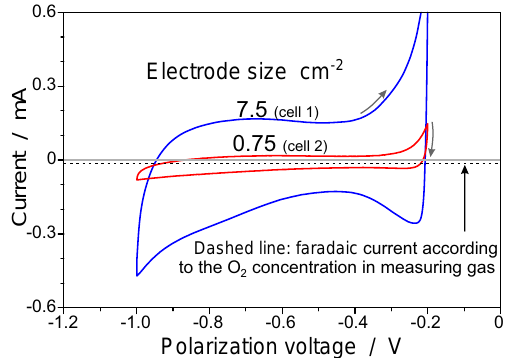
Figure 4. Voltammograms about the variation of the electrode size; measuring gas: 5vol.ppm O 2 in N 2 ; gas flow rate: 10sccm; cell temperature: 750 ◦ C; open-circuit potential: − 235mV; poten- tial scan rate: 200mVs − 1 ; start potential: − 0 . 20V; the second cy- cle is shown.